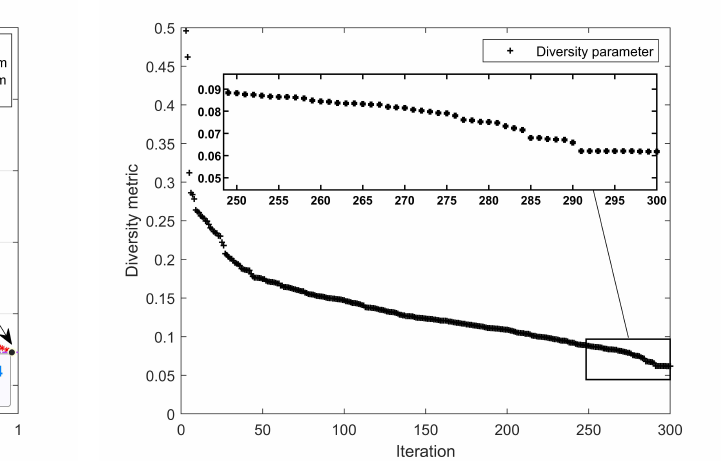
Figure 7. The convergence of SENSGA-II based on diversity